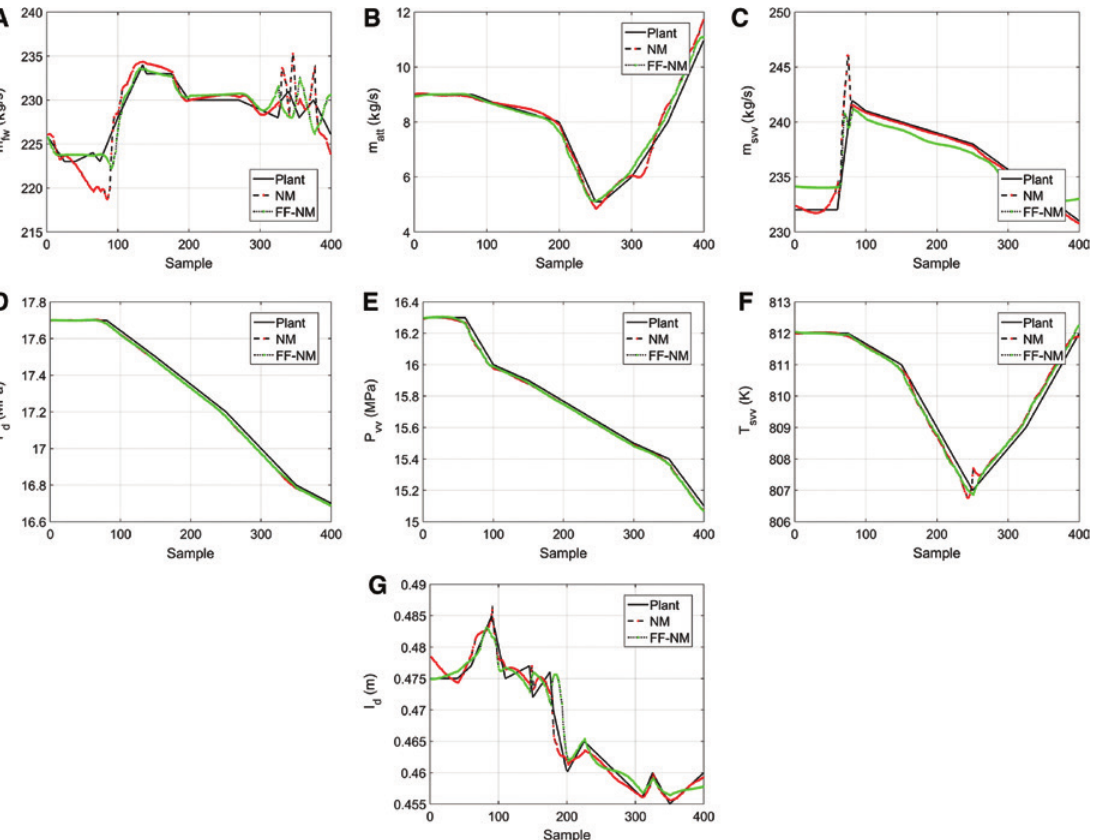
Figure 5: Correlation between the Output of Different Models from Test Case 2 – Set A.